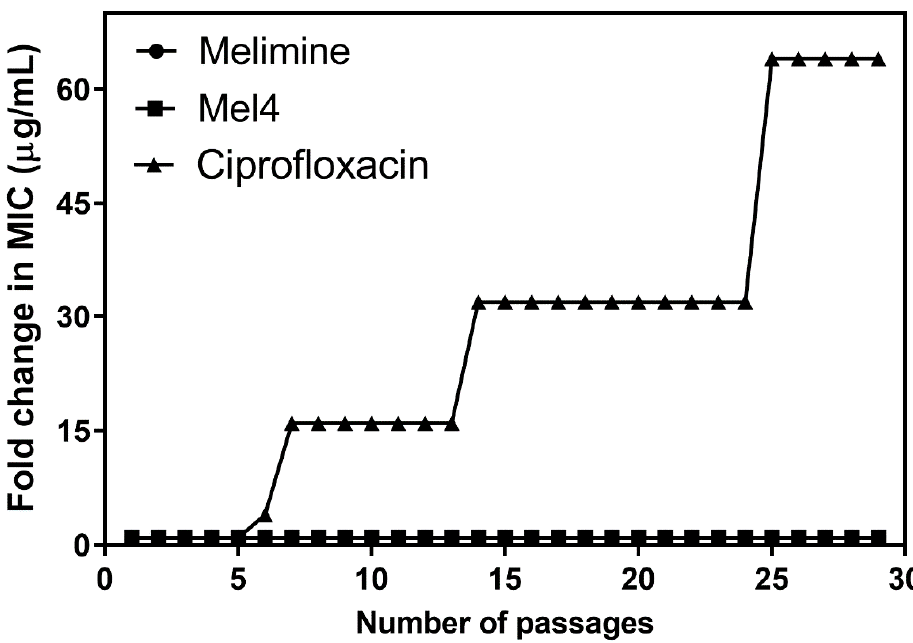
Figure 2. Change in resistance of P. aeruginosa ATCC 27853 to ciprofloxacin, melimine or Mel4 following serial passage at sub-MIC for 30 days. The MIC of melimine and Mel4 did not change, and values overlap at the bottom of the figure.